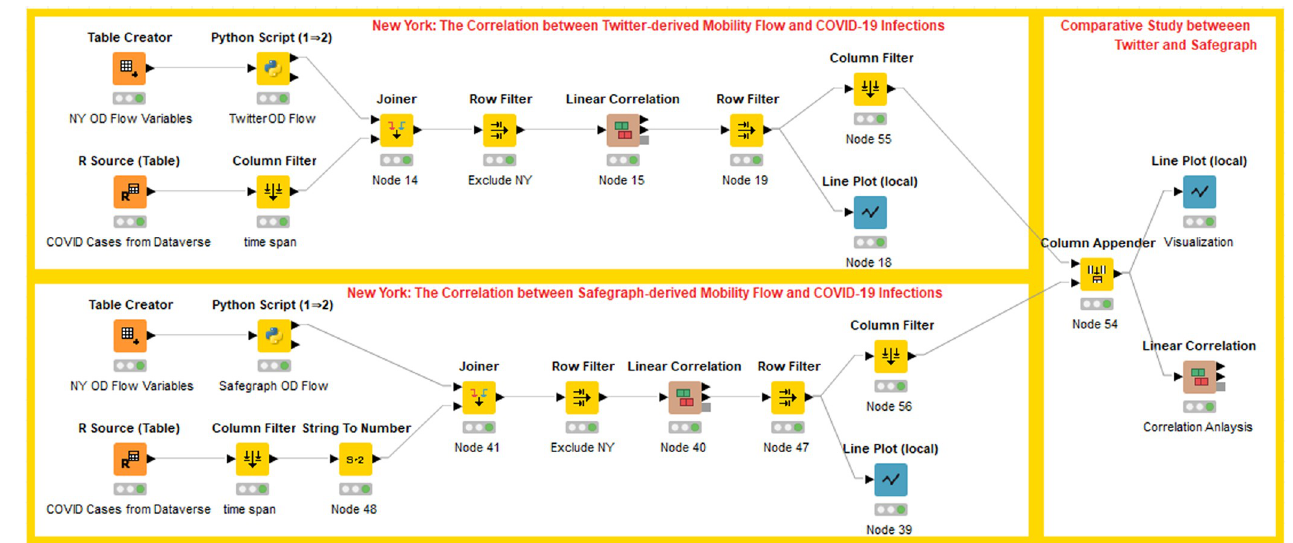
Fig 11. The correlation analysis of human mobility and COVID-19 infection cases in the U.S.